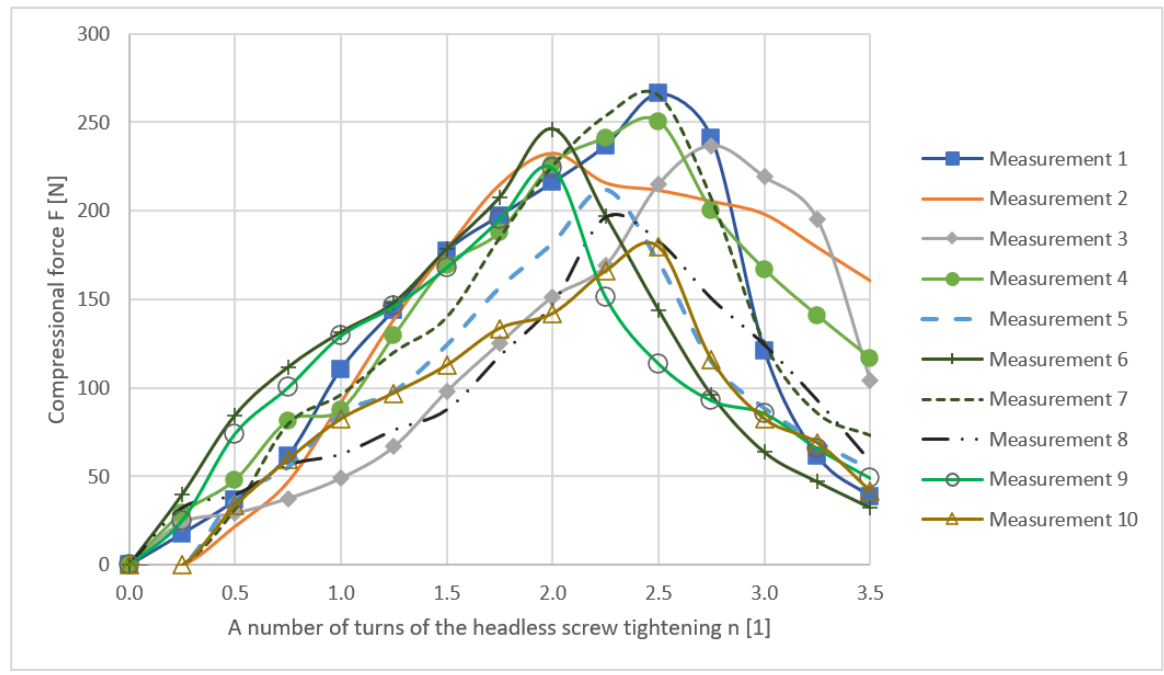
Figure 13. Axial forces during headless screw tightening.